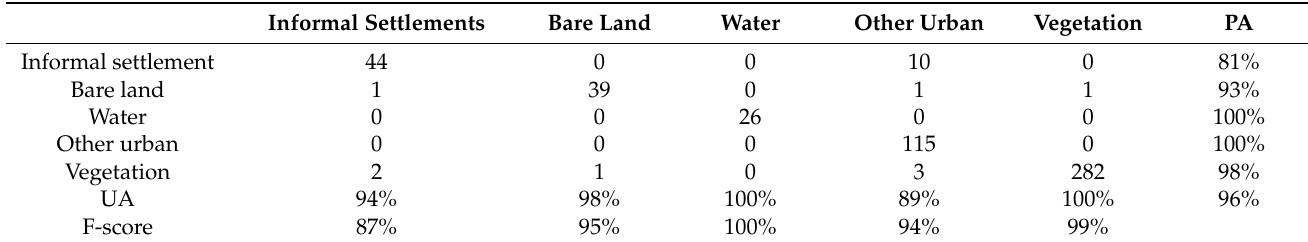
Table 4. Confusion matrix derived from LULC classification. PA: Producer’s Accuracy; UA: User’s Accuracy, and Overall Accuracy in bold.